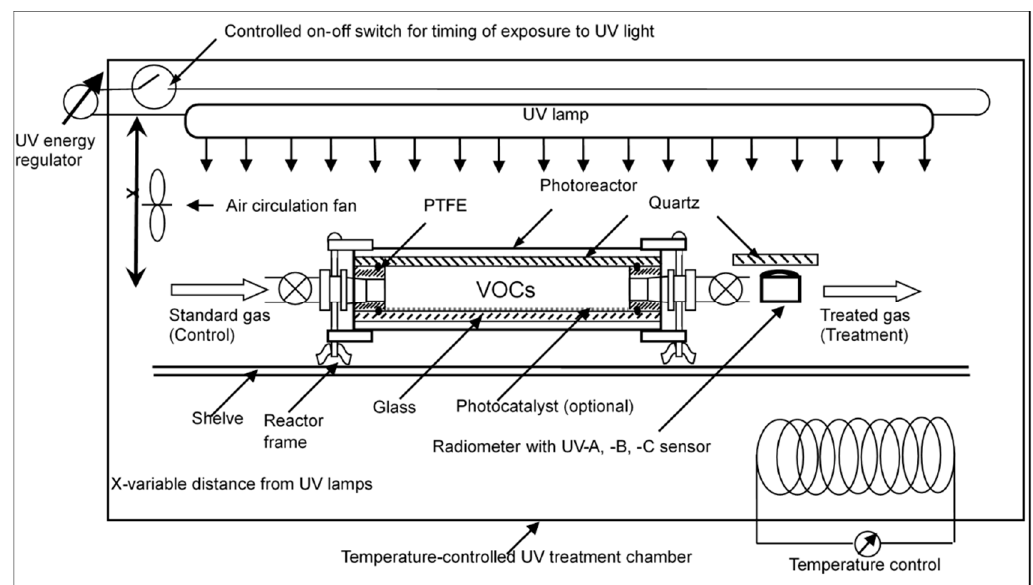
Figure 6. A scheme of the lab-scale UV photoreactor (0.57 L) in a temperature-controlled chamber. The system includes a data acquisition system for (1) UV lamp status and electric voltage and current; (2) UV light intensity; and (3) light intensity controlled with distance “x” between the lamp and